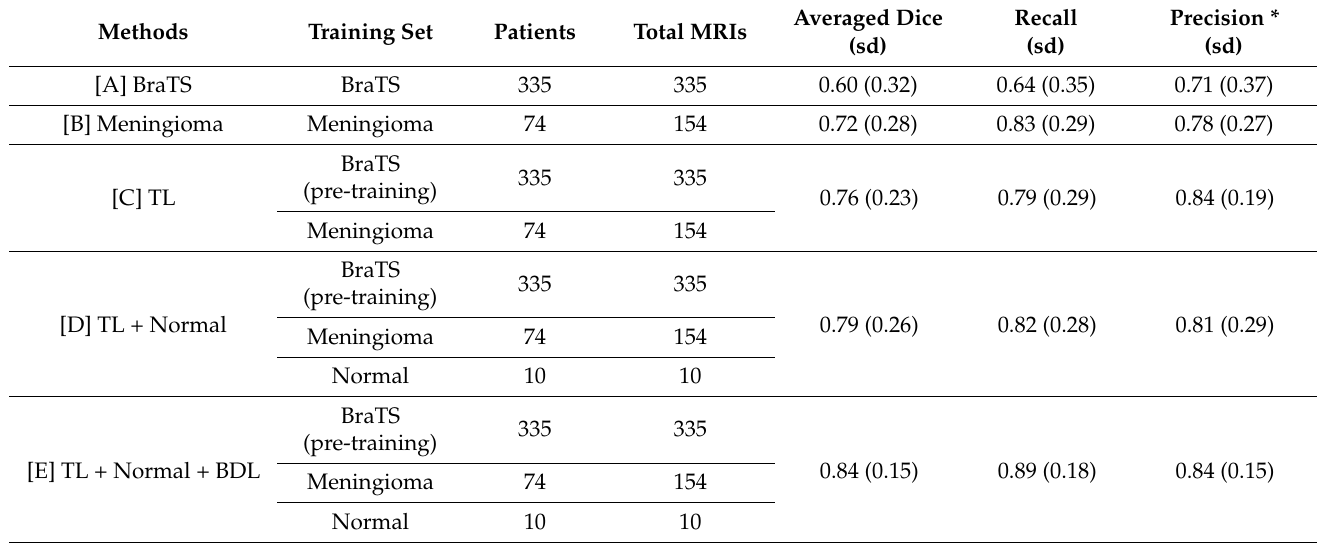
Table 1. Model inference performance. All Dice scores are averaged against the test set (17